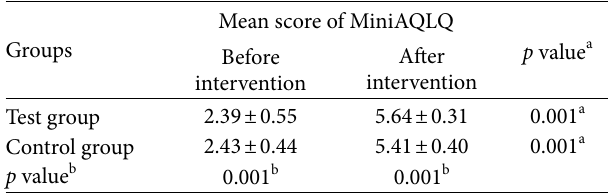
Table 2: Quality of life of asthmatic patients before and after